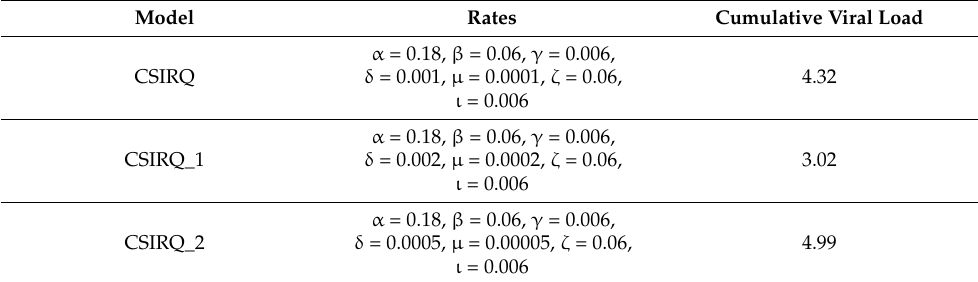
Table 1. Cumulative Viral load estimations for different scenarios of the CSIRQ model (t = 365 days).